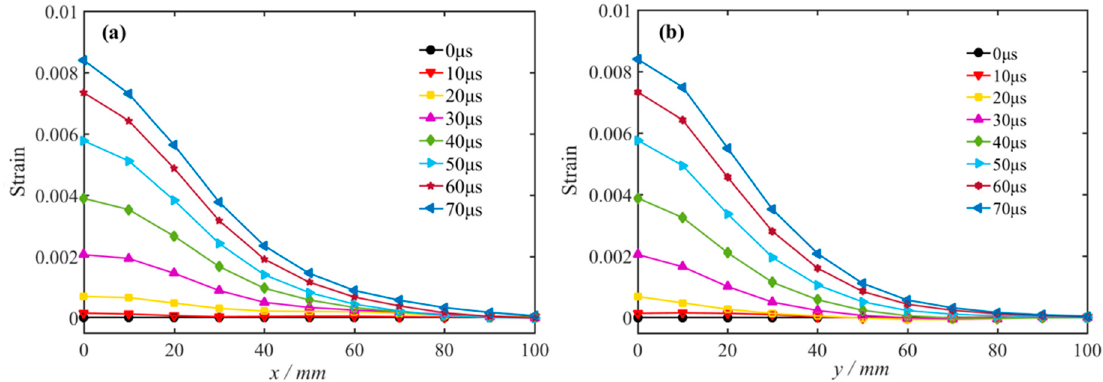
Figure 4. Variation of ε 1 at various points on the x and y axes at different moments in case of no static load: ( a ) x axis direction; ( b ) y axis direction.